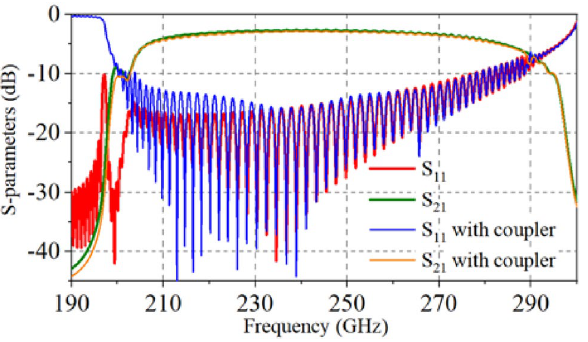
Figure 4. Transmission performances of the slow-wave circuit with and without couplers.